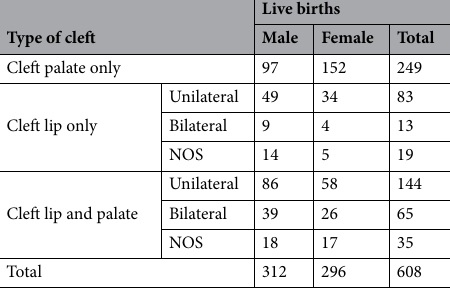
Table 1. Live births by cleft-type and gender. NOS not otherwise specified (non-classifiable cleft sub-type in ICD 9 & 10).